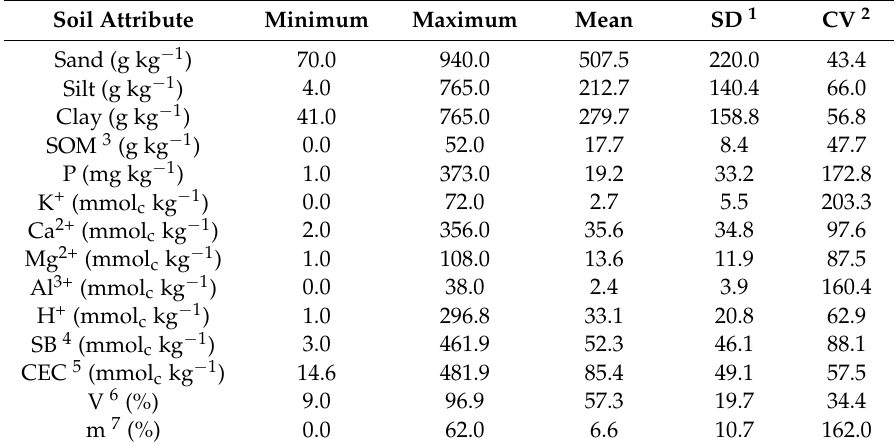
Figure 5. Soil textural triangle of the measured samples, representing variation [21]. Red spots indicate sandy soil, yellow indicates loamy soil, blue is clay-loamy soil, green represents clay soil, and light blue shows silty soil. Table 2. Summary statistics of laboratory determined soil attribute measurements.